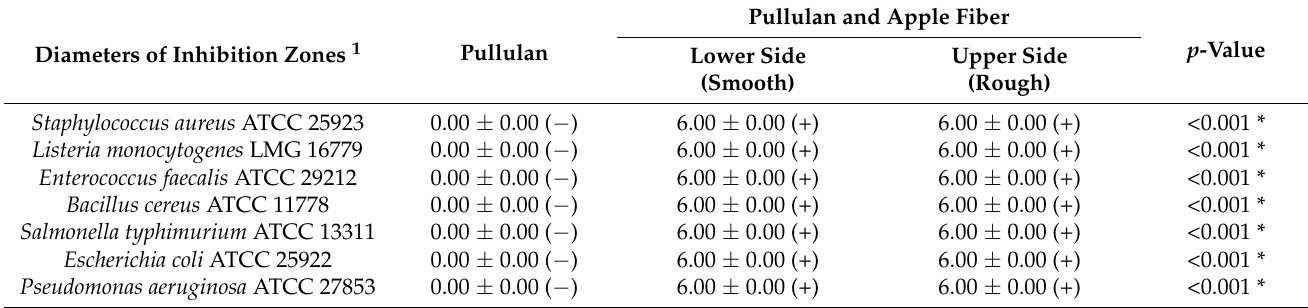
Table 5. Antibacterial properties of the biocomposite